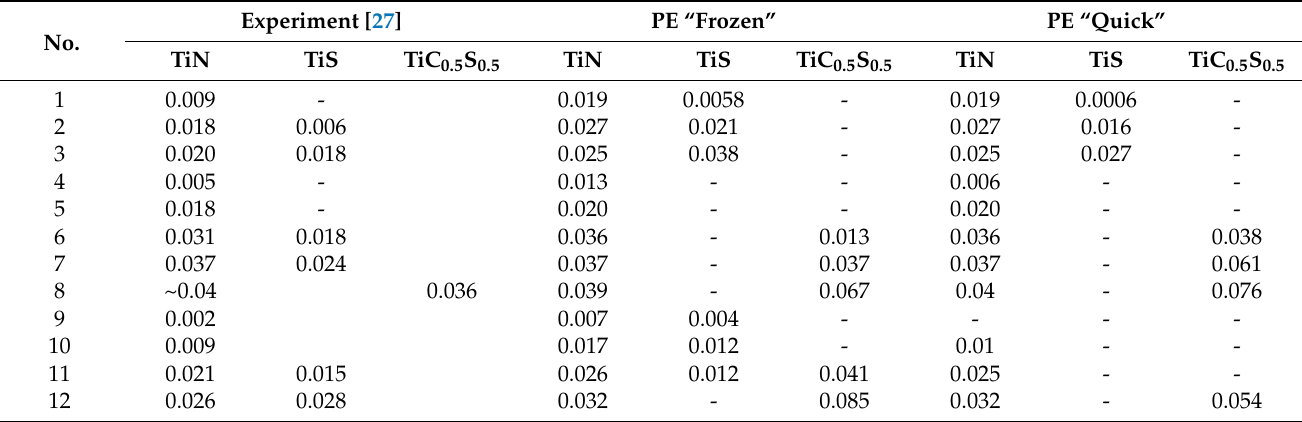
Table 4. Comparison of calculated (this work) and experimental [27] amounts (weight %) of coarse particles of TiN (precipitated from liquid phase), TiS and TiC 0.5 S 0.5